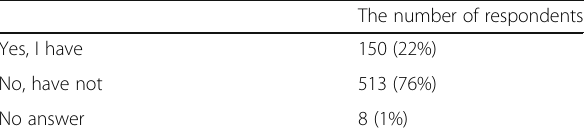
Table 5 Number, implants (whether placed by the visiting dentist), and oral self-care of patients receiving home-visit dental care seen by dentists who provided home-visit dental